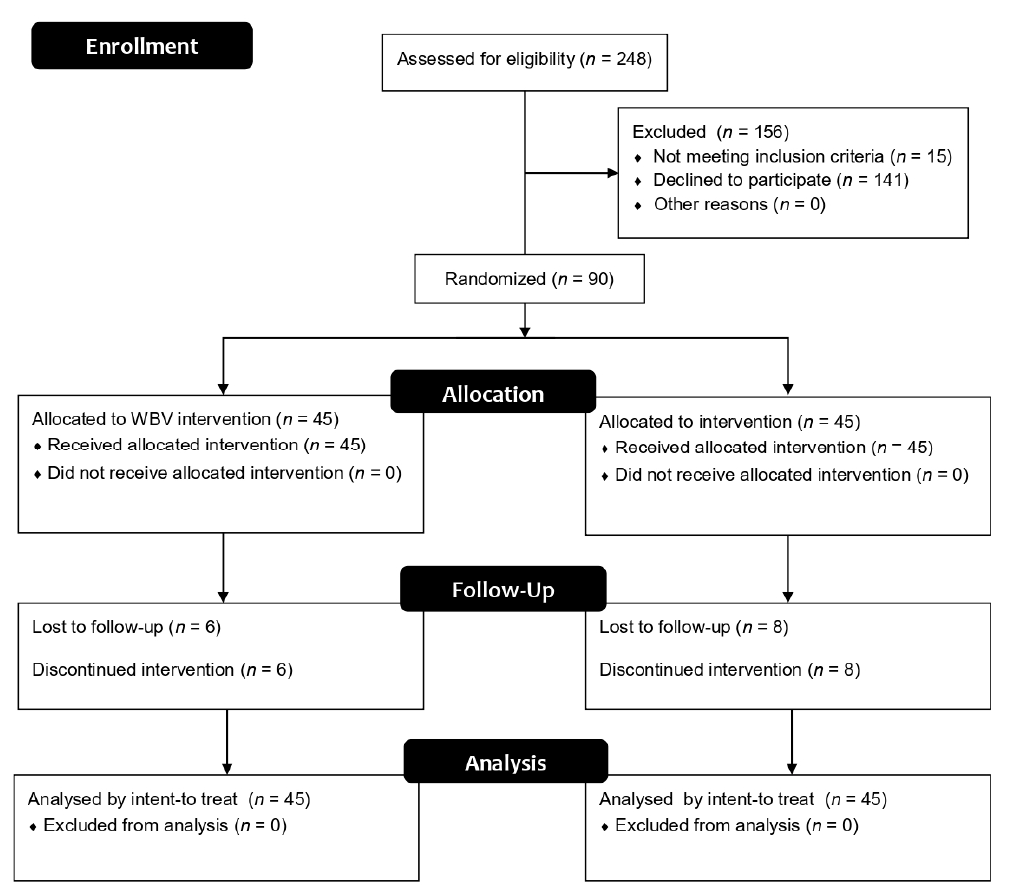
Figure 1. Flow diagram of participants.